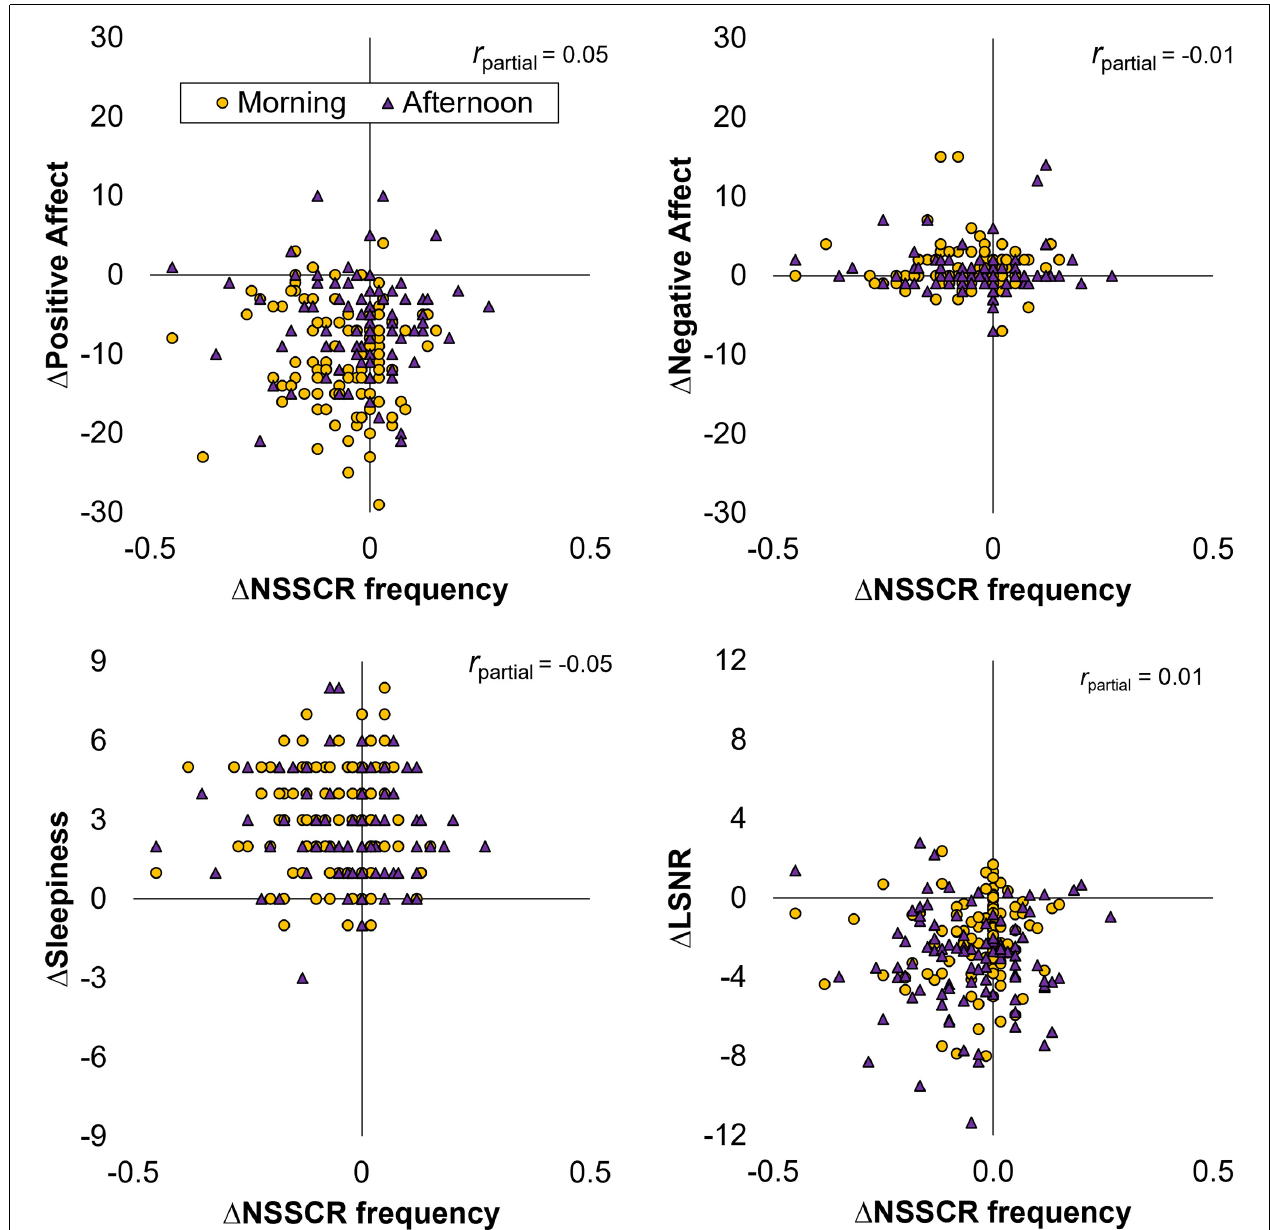
FIGURE 3 | Scatter plots of the change across days ( ∆ ) in the frequency of NSSCR vs. positive affect (top left), negative affect (top right), subjective sleepiness (bottom left), and LSNR (bottom right) for participants in the TSD